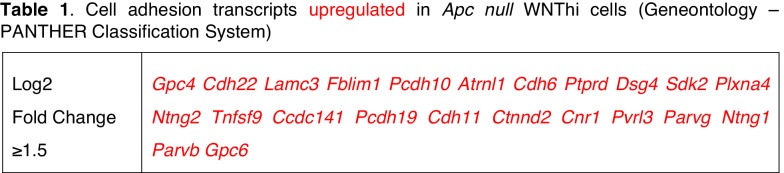
Figure 2—figure supplement 2—source data 1.Cell adhesion transcripts upregulated in Apc null WNThi cells (Geneontology – PANTHER Classification System).